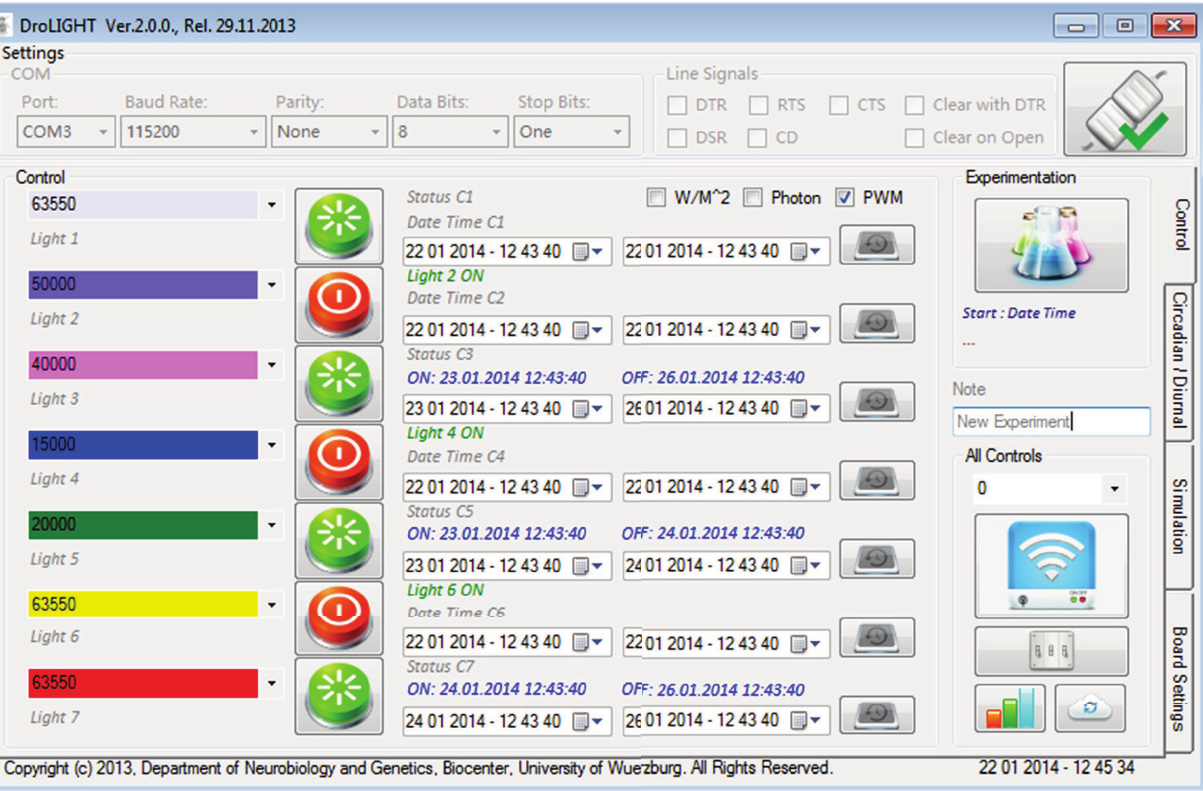
Figure 10. DroLIGHT’s main graphical user interface. It is a scientific software solution towards neurobiology and photobiology, capable of controlling and automating the hardware that produces different colors of lights via Light Emitting Diodes (LEDs). It provides experimental data management system, circadian and diurnal rhythm generation, 3D visualization of system’s performance and experimentation details